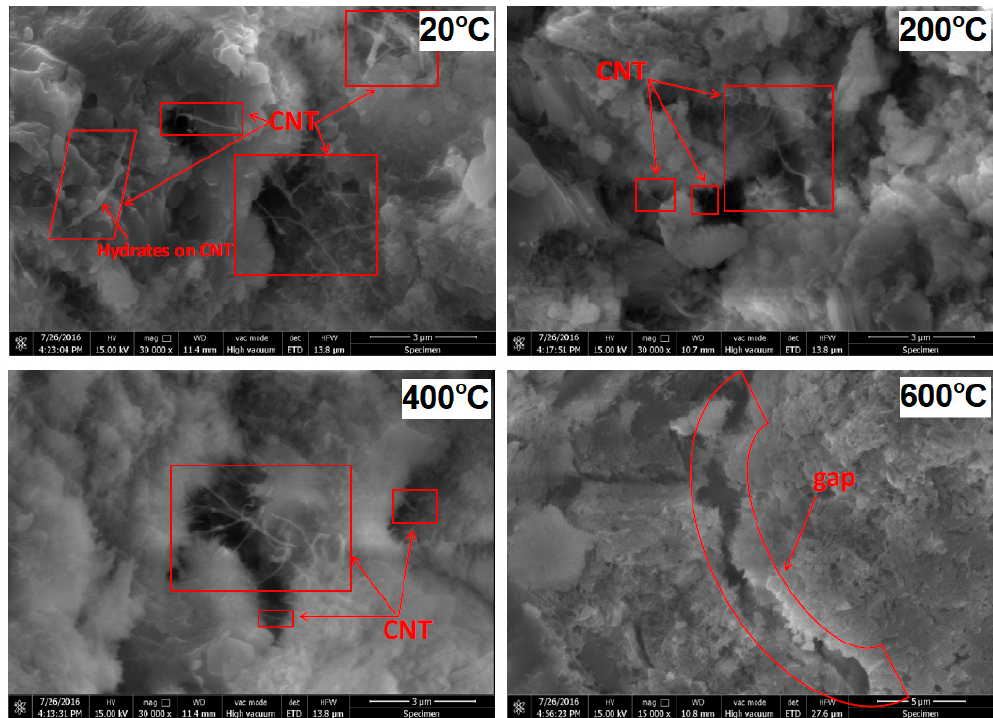
Figure 9. Scanning electron microscope (SEM) micrographs showing the bridging effect of MWCNTs in a cement matrix before (20 °C) and after exposure to elevated temperatures of 200, 400, and 600 °C. Reproduced with permission from [63]. Copyright Elsevier, 2017.